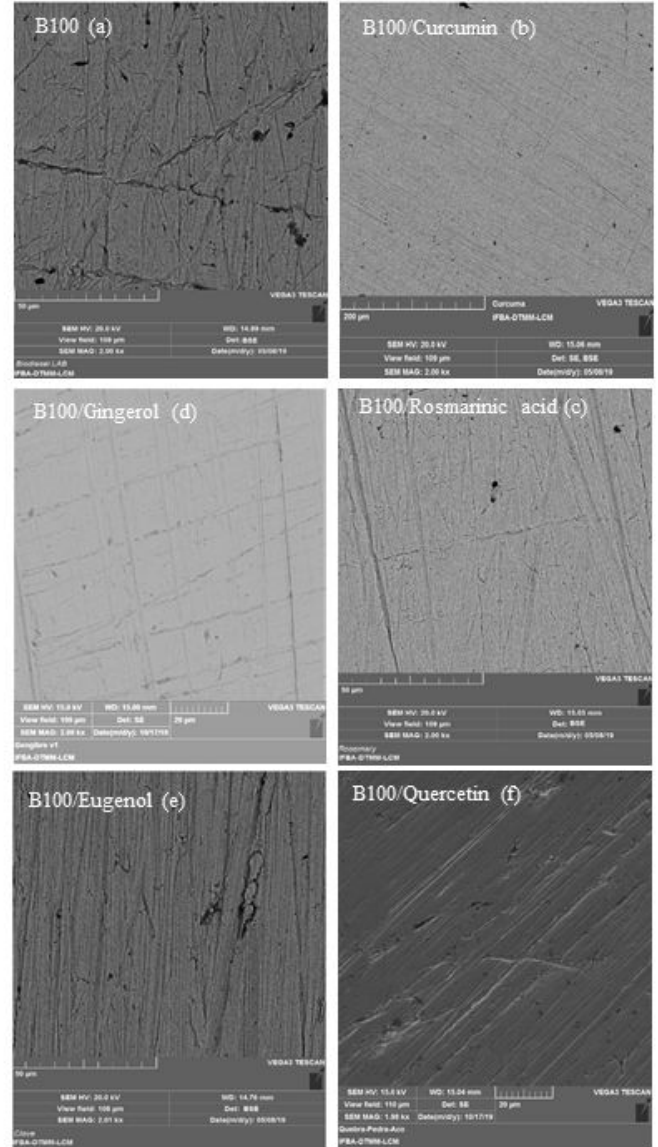
Figure 6. SEM micrographs of carbon steel surface after B100 exposure for 90 days in the absence and presence of